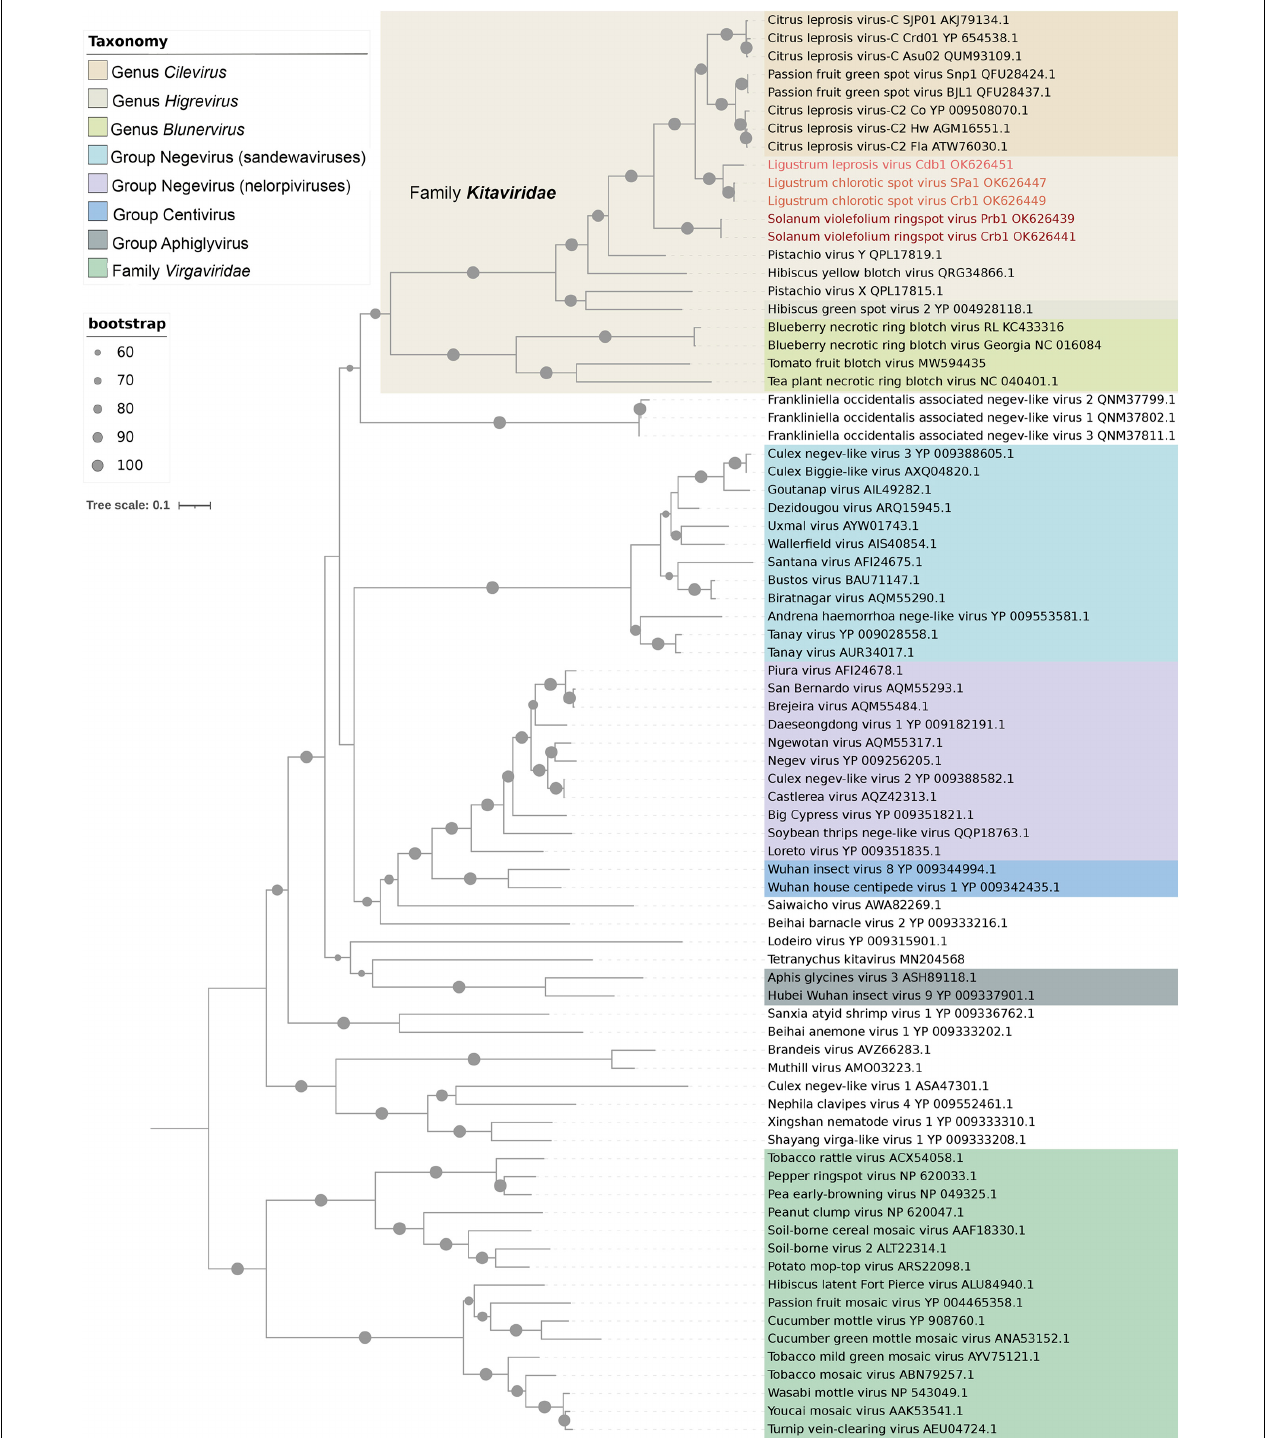
FIGURE 5 | Phylogenetic reconstruction for viruses of the family Kitaviridae . Isolates of Solanum violifolium ringspot virus, Ligustrum chlorotic spot virus, and Ligustrum leprosis virus are highlighted in different red tones. The maximum-likelihood phylogenetic tree is based on the deduced amino acid sequences of the RNA-dependent RNA polymerase. The tree was rooted using viruses of the family Virgaviridae as an external group. Phylogenetic informative regions of the multiple sequence alignment included 546 residues that were selected using BMGE software (Criscuolo and Gribaldo, 2010) and its evolutionary history was inferred based on the model LG+F+I+G4 (Le and Gascuel, 2008). The bootstrap support values (1,000 replications) of branches greater than 60% are indicated with solid black circles next to the corresponding nodes. The scale bar specifies the average number of amino acid substitutions per site.